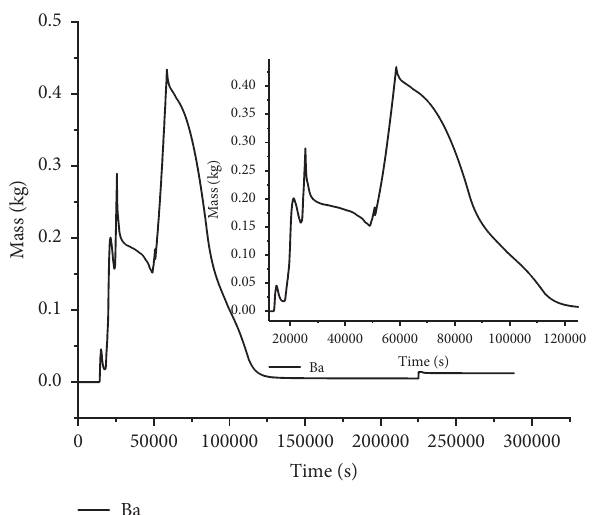
Figure 15: Release of Ba in the